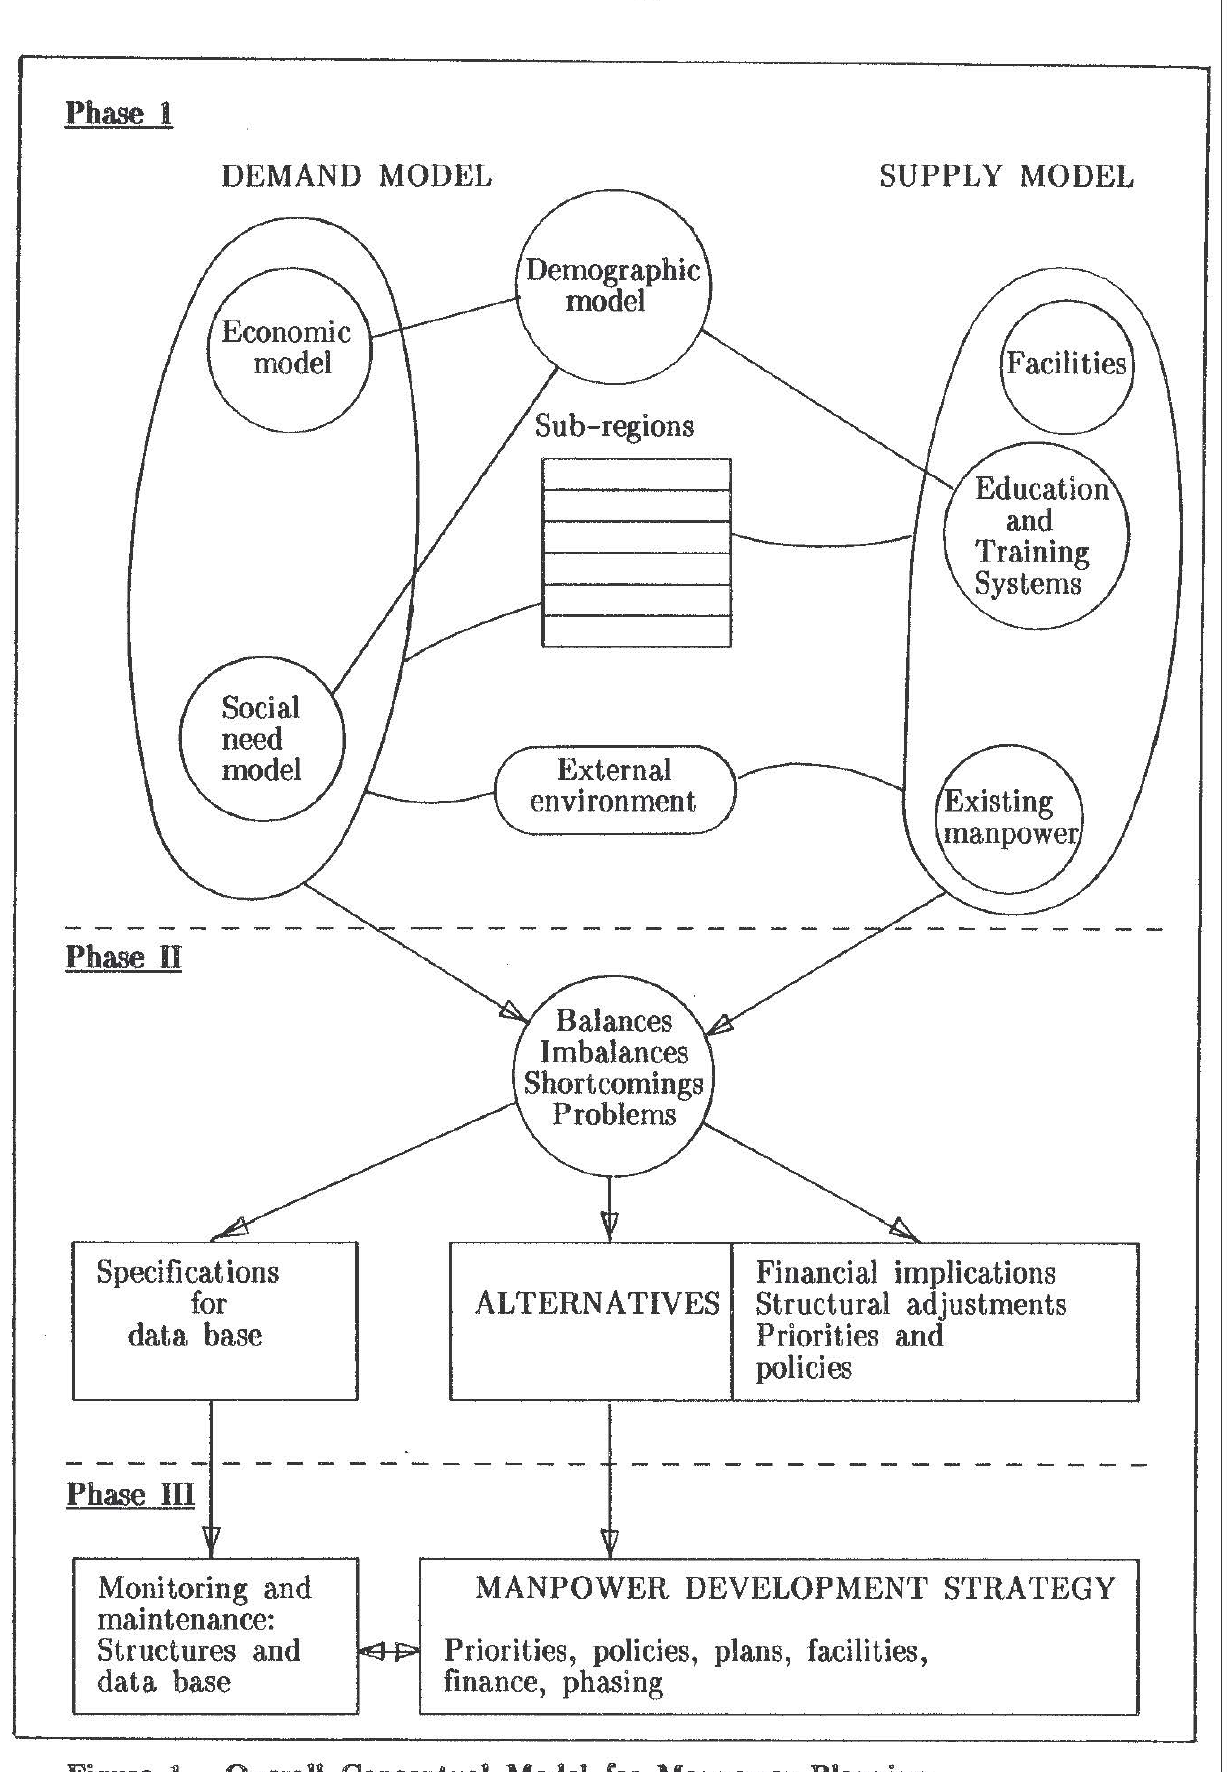
Figure 1. Overall Conooptual Model for Manpower